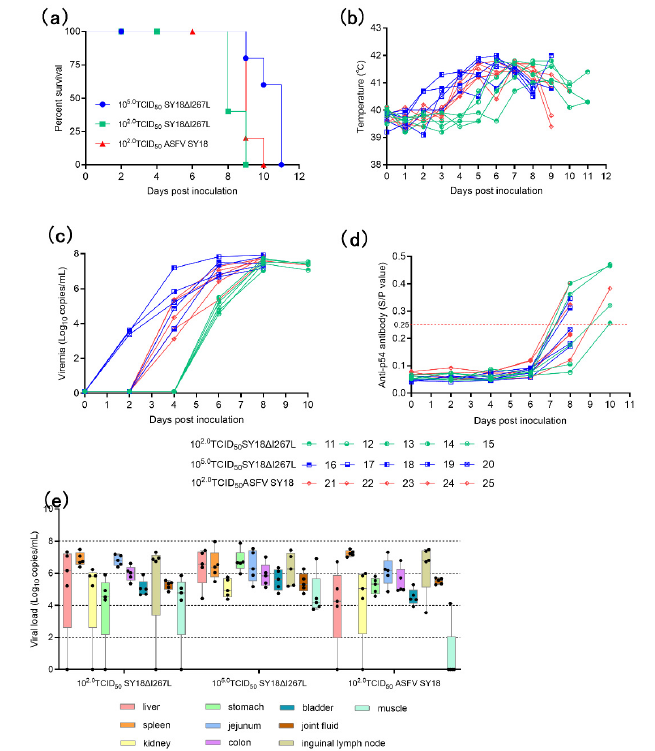
Figure 4. The results of survival rate, temperature, viremia, antibodies, and viral load of tissues. ( a ) The survival rate of the animal post inoculation with 10 2.0 TCID 50 and 10 5.0 TCID 50 SY18 Δ I267L and 10 2.0 TCID 50 ASFV SY18. ( b ) The temperature of the animal post inoculation. ( c ) The viremia of the animal post inoculation. ( d ) The value of anti-p54 antibody of the animal post inoculation. The value of P (OD 450 )/N (OD 450 ) greater than 0.25 is considered positive. The red dotted line represents P (OD 450 )/N (OD 450 ) equal to 0.25. ( e ) The viral load in the tissues of the animal euthanized in extremis. The black dots represent the viral load of the individual in the tissue.